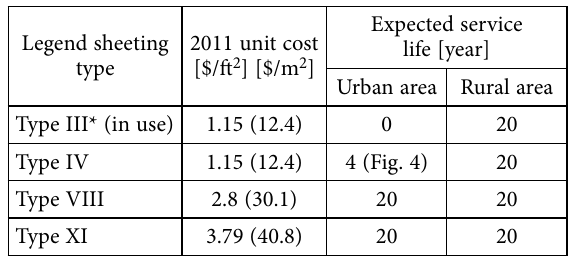
Table 4. Unit cost and service life for different legend sheeting types